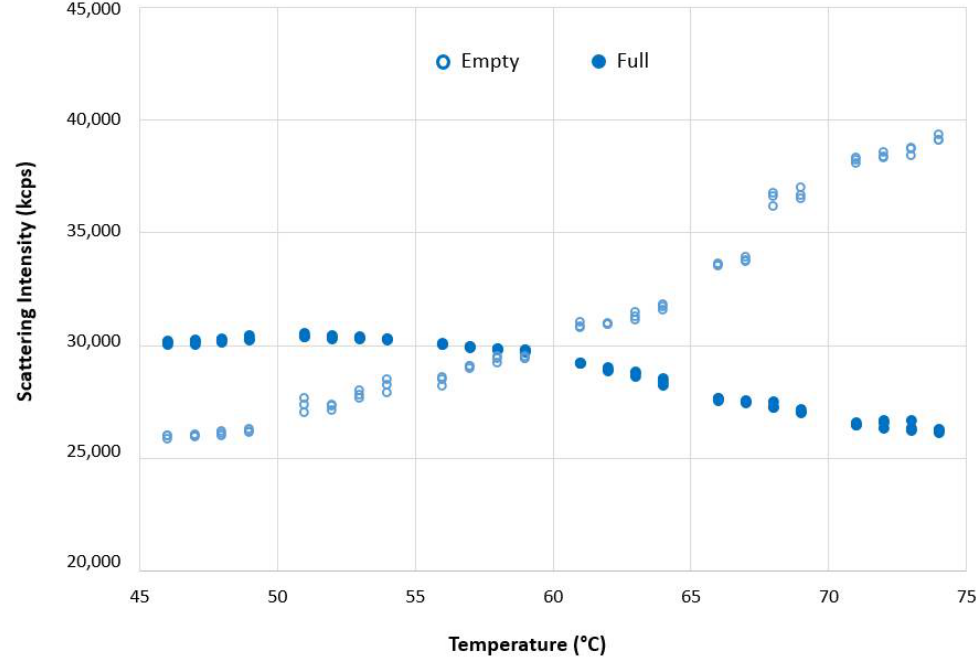
Figure 7. A plot of the scattering intensities (in kilocounts per second (kcps)) as a function of temperature for full and empty rAAV5 samples.